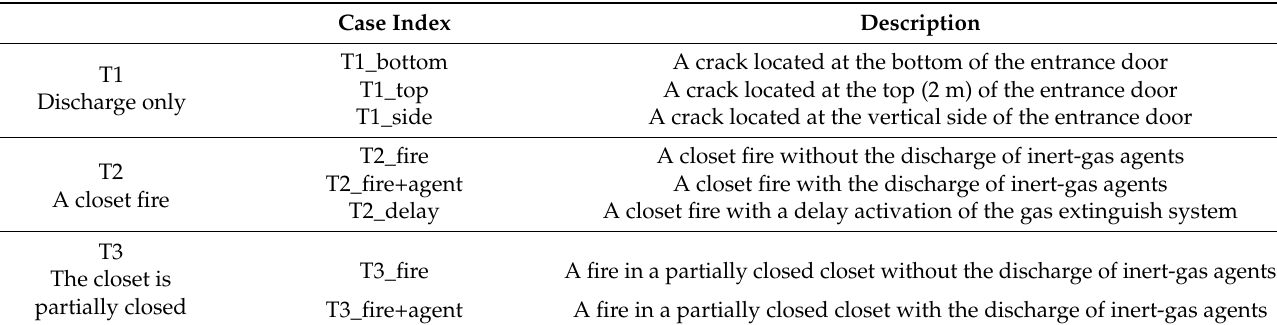
Table 3. Summary of the simulation